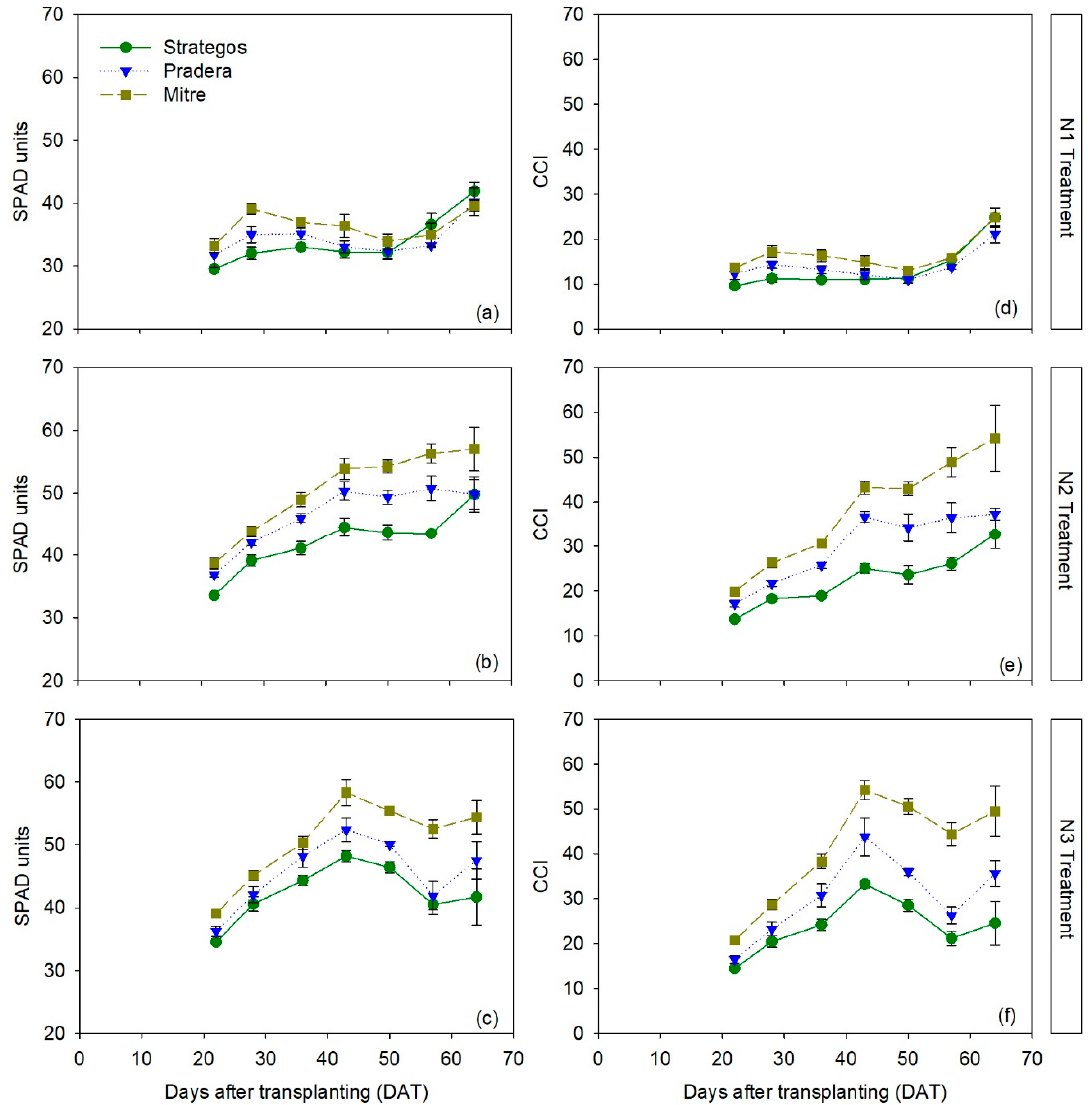
Figure 2. Temporal dynamics of SPAD (panels a – c ) and chlorophyll content index (CCI) measurements (panels d – f ) of three cultivars of cucumber ( Cucumis sativus L. ‘Strategos’, ‘Pradera’ and ‘Mitre’) under three N treatments (N1, N2 and N3). Values are means ± SE.